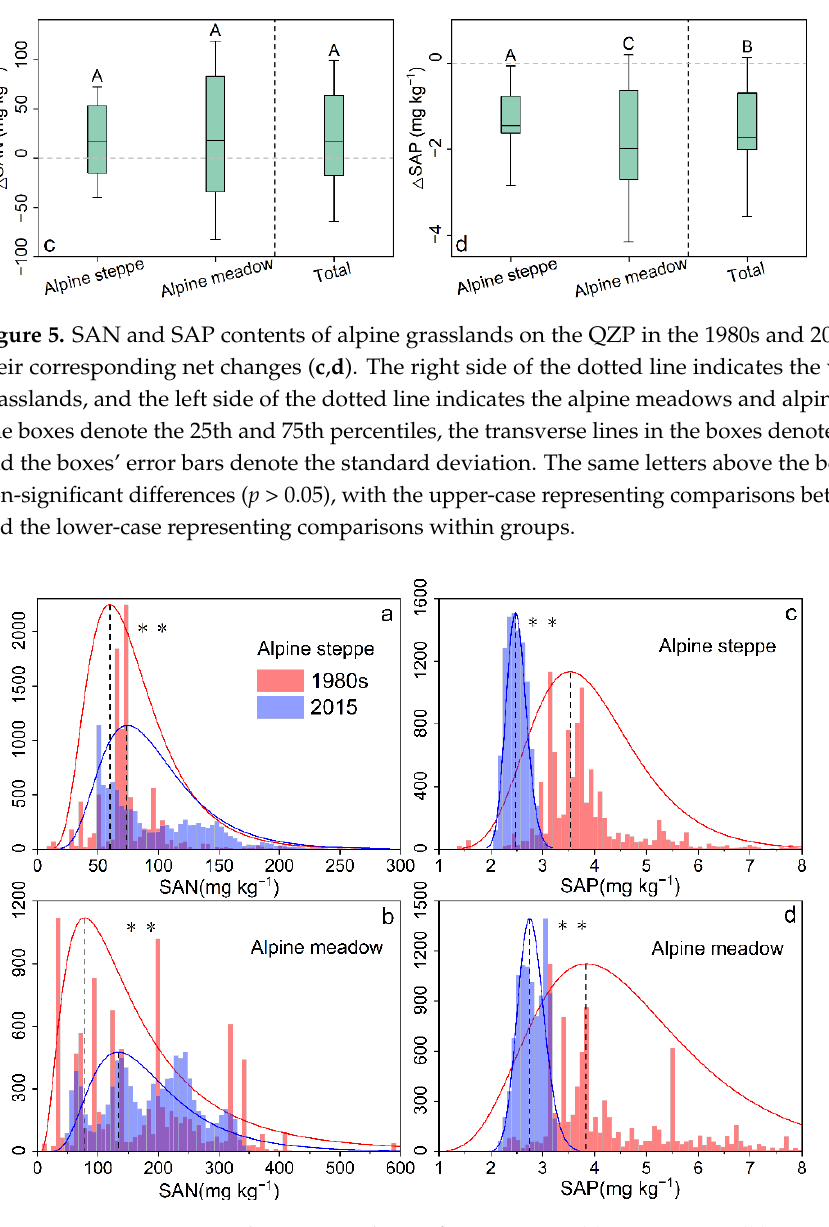
Figure 7. Relationship between SAN and SAP ( a ), Δ SAN and Δ SAP ( b ) in alpine meadows and alpine steppes. The spatial distribution of Δ SAN and Δ SAP showed heterogeneous geographical pat ‐ terns for SAN and SAP dynamics (Figure 8a,c). Spatially, 60% of the alpine grasslands on the QZP showed an increase in SAN and 96% showed a decrease in SAP. Overall, the dynamics of SAN and SAP showed a certain degree of spatial correlation, with the Mo ‐ ran’s I of 0.513 ( P < 0.001) and 0.509 ( P < 0.001), respectively. Additionally, the local spatial autocorrelation of Δ SAN and Δ SAP was obvious, but the distribution of cold and hot spots exhibited spatial heterogeneity (Figure 8b,d). The hot spots (high ‐ value aggregation) of Δ SAN are mainly located in the northern part of Ali, north of Shuanghu, Sanjiangyuan, and Qinghai Lake, and the cold spots (low ‐ value aggregation) are mainly found in the central part of Ali, Shigatse, western Naqu, and Qilian Mountains, etc. The hot spots of Δ SAP are mainly distributed in Qiangtang, Ali, Cocosili, and Sanjiangyuan, while the cold spots are mainly located in the western part of Naqu, Qilian Mountains, and northern Sichuan.